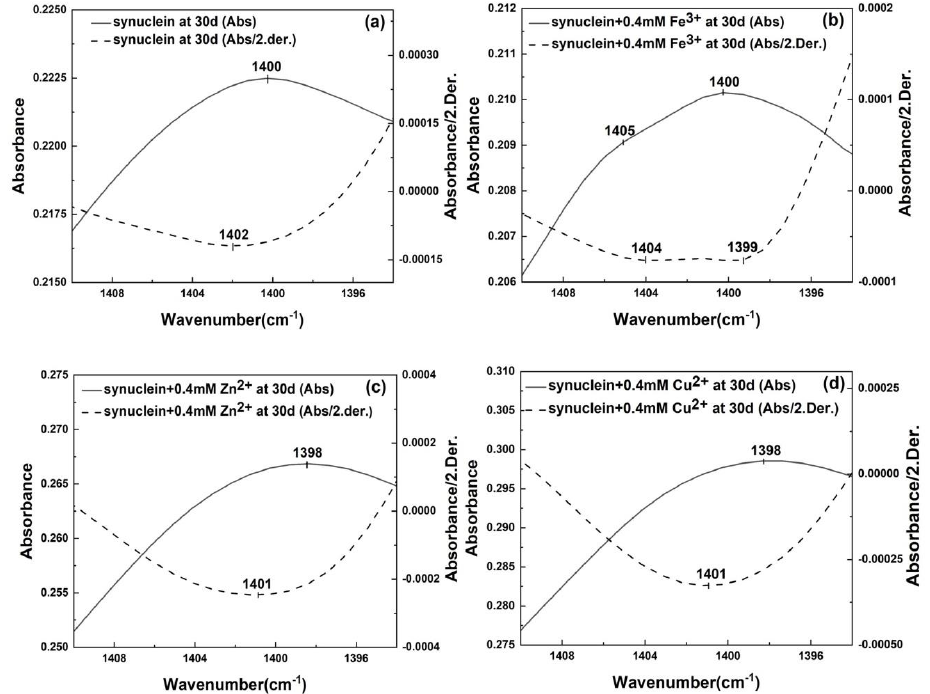
Figure 4. FTIR spectra of α -synuclein amyloid fibril under the influences of different metal ions and their corresponding second derivative spectra in the COO − symmetric stretching region. ( a ) control;